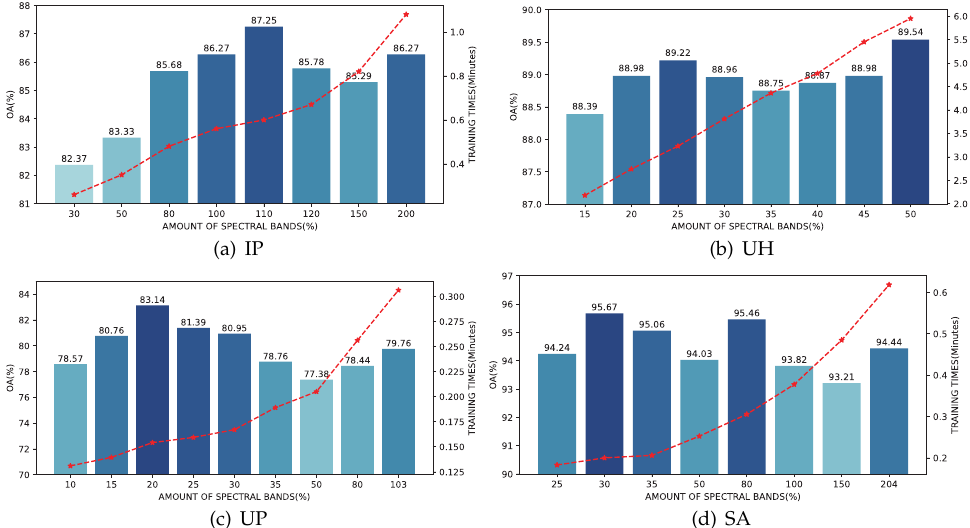
Figure 3. Classification OA results (%) and training time (minutes) on the validation sets by retaining different numbers of components during the PCA operation; ( a ) is the result of IP using 1% training samples and validation samples, while ( b – d ) are the results of UH, UP, and SA using 0.1% training samples and validation samples,